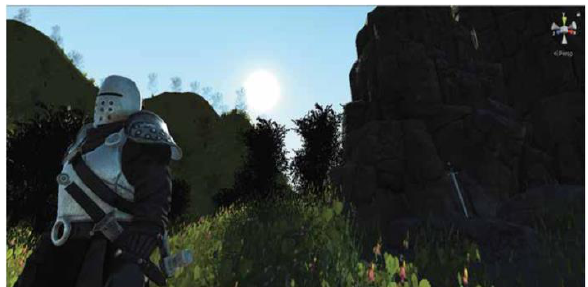
Figure 8: The avatar of the game.